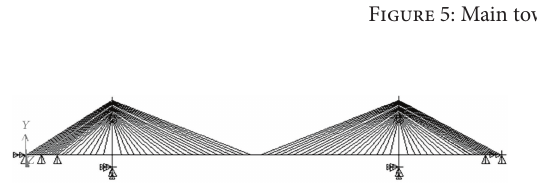
Figure 5: Main tower general arrangement [21].